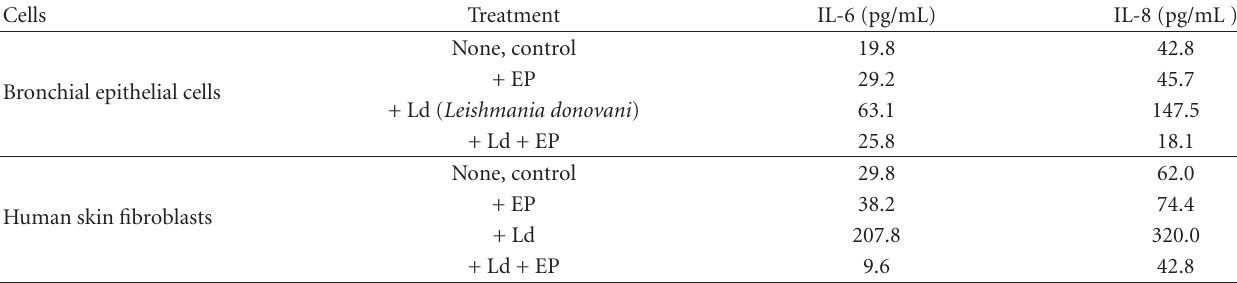
Table 9: E ff ect of EP on Leishmania -induced secretion of